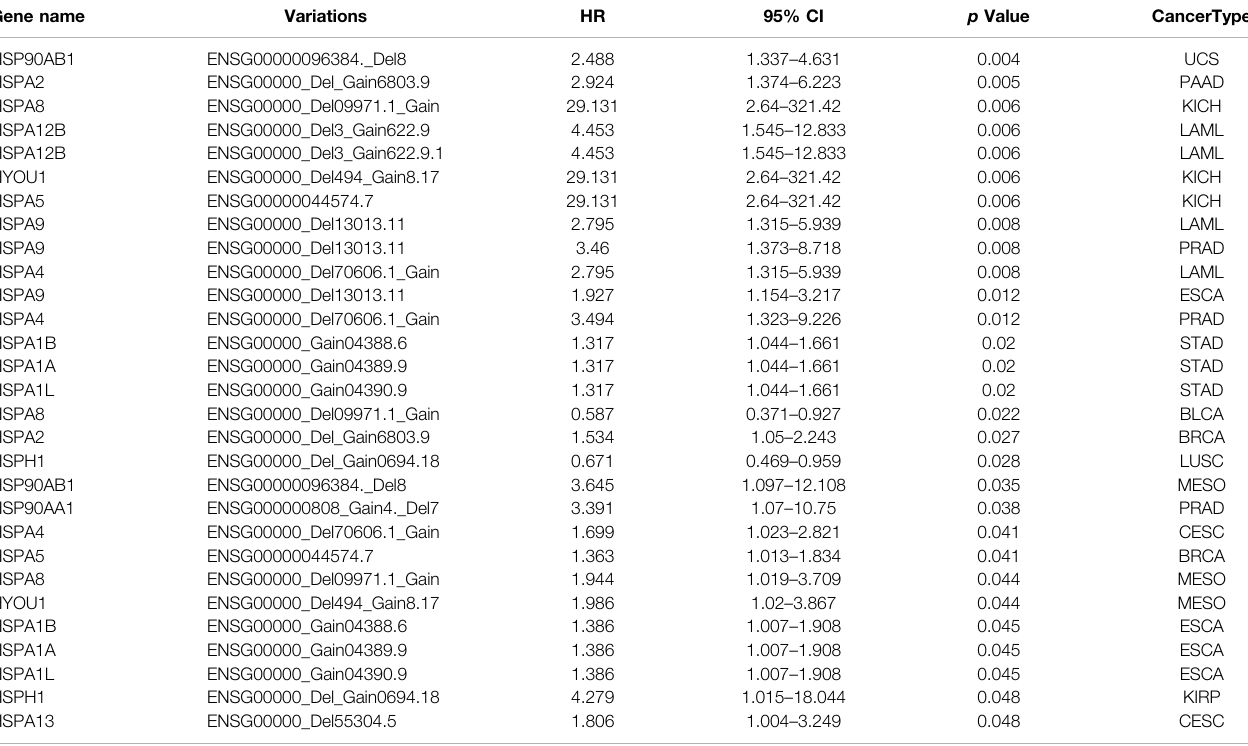
TABLE 6 | Correlations between copy number variations and prognosis of heat shock proteins in pan-cancer.